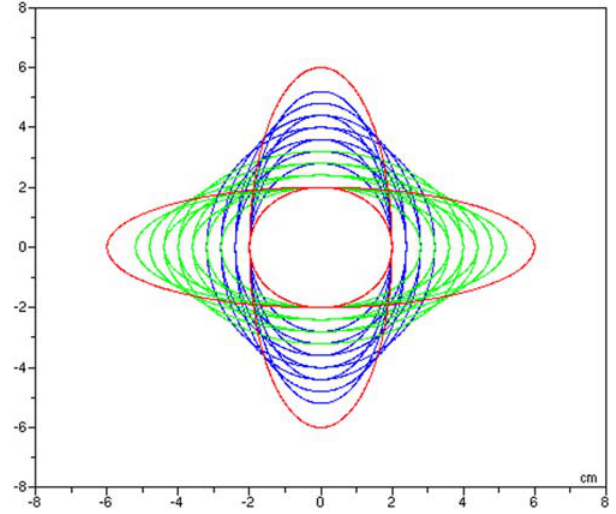
Figure 4. All ellipses used in experiment 2: In red, the three references trajectories used before and after each training session; In green and blue, the trajectories used during the training sessions, equidistant in the choice of their diagonals (eccentricity).